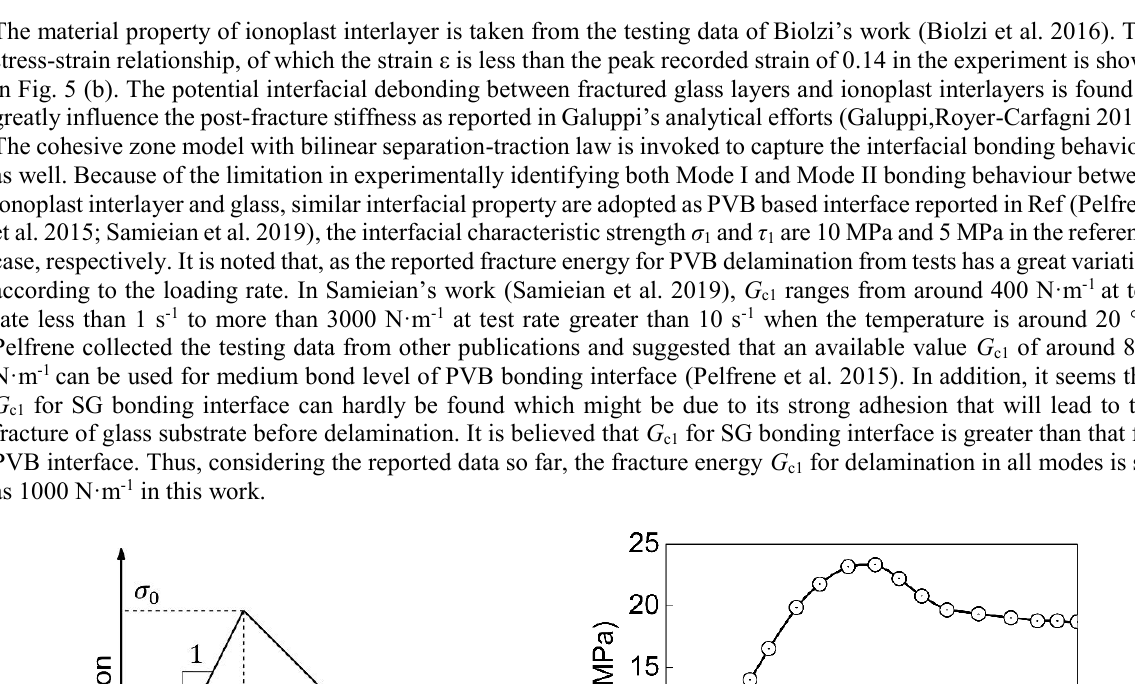
Fig. 4 Testing specimen and corresponding numerical model.